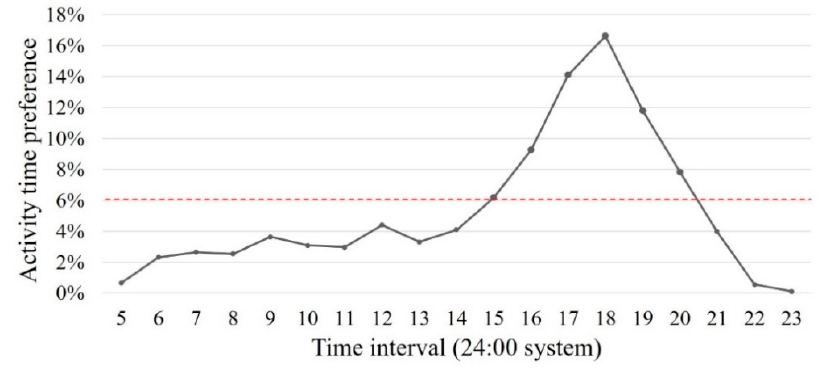
Figure 7. Time preference of visit.